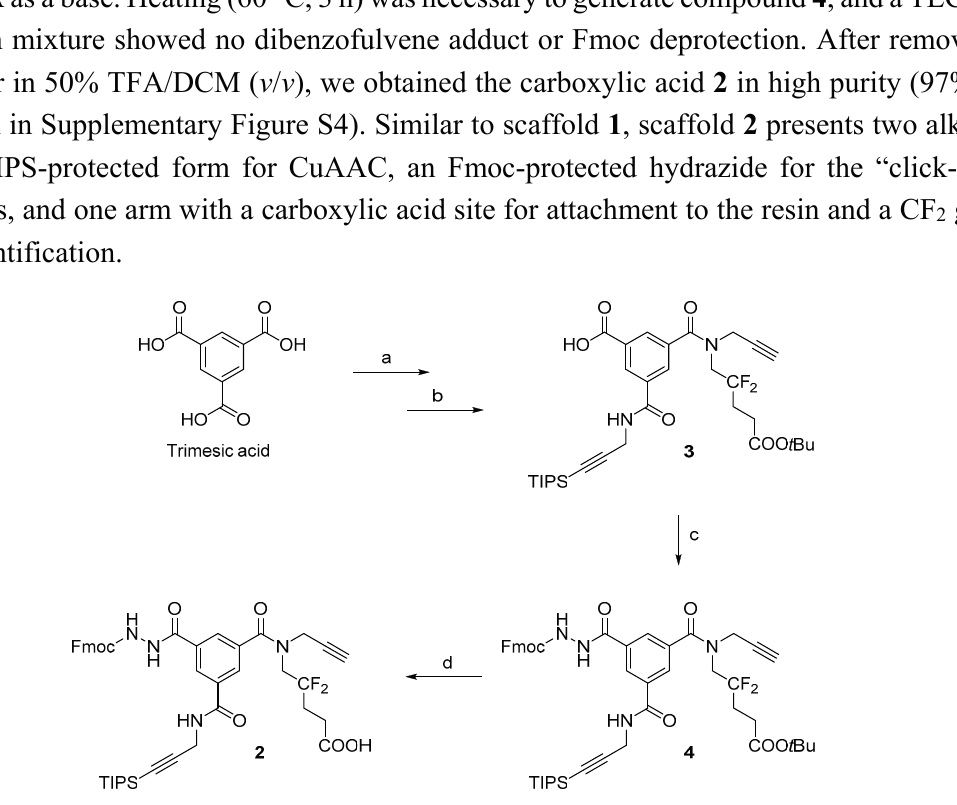
Scheme 2. Synthesis of scaffold 2 . Reaction conditions: for the synthesis of 3 (steps ( a , b